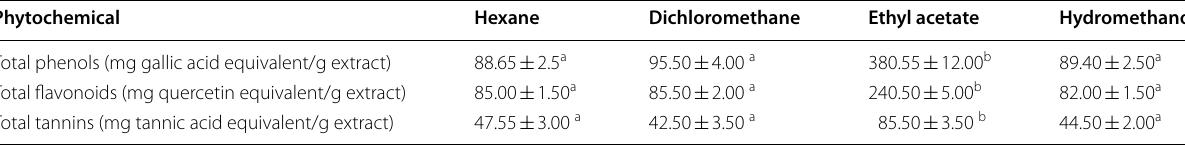
a, b are different levels of significance at p < 0.05. a is significantly different from b and vice versa. The use of such alphabets is to show the homogenous sets which would bear same alphabet so that the different sets can easily be identified Values are expressed as mean SEM ( n 3). Values in the same row with different superscripts are significantly different ( p < 0.05) from each other ± =